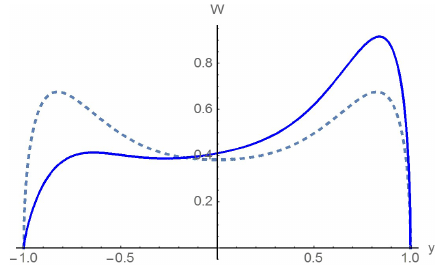
Figure 7. The probabilistic density function of the shoreline vertical displacement in the linear theory (the dashed line) and nonlinear theory (the solid